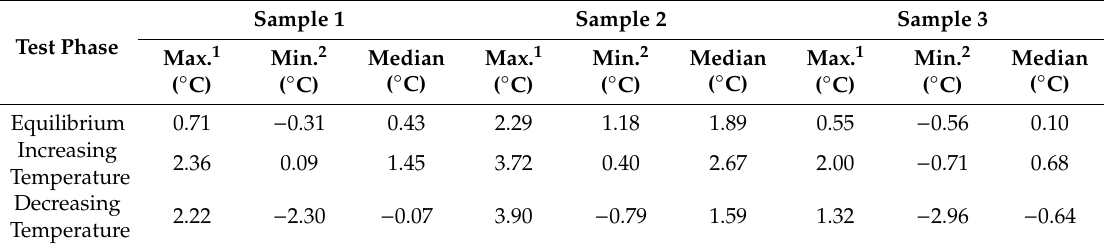
Table 2. Maximum, minimum and median value for the di ff erence between temperature measured by temperature sensor and thermocouple in each phase for each sample.